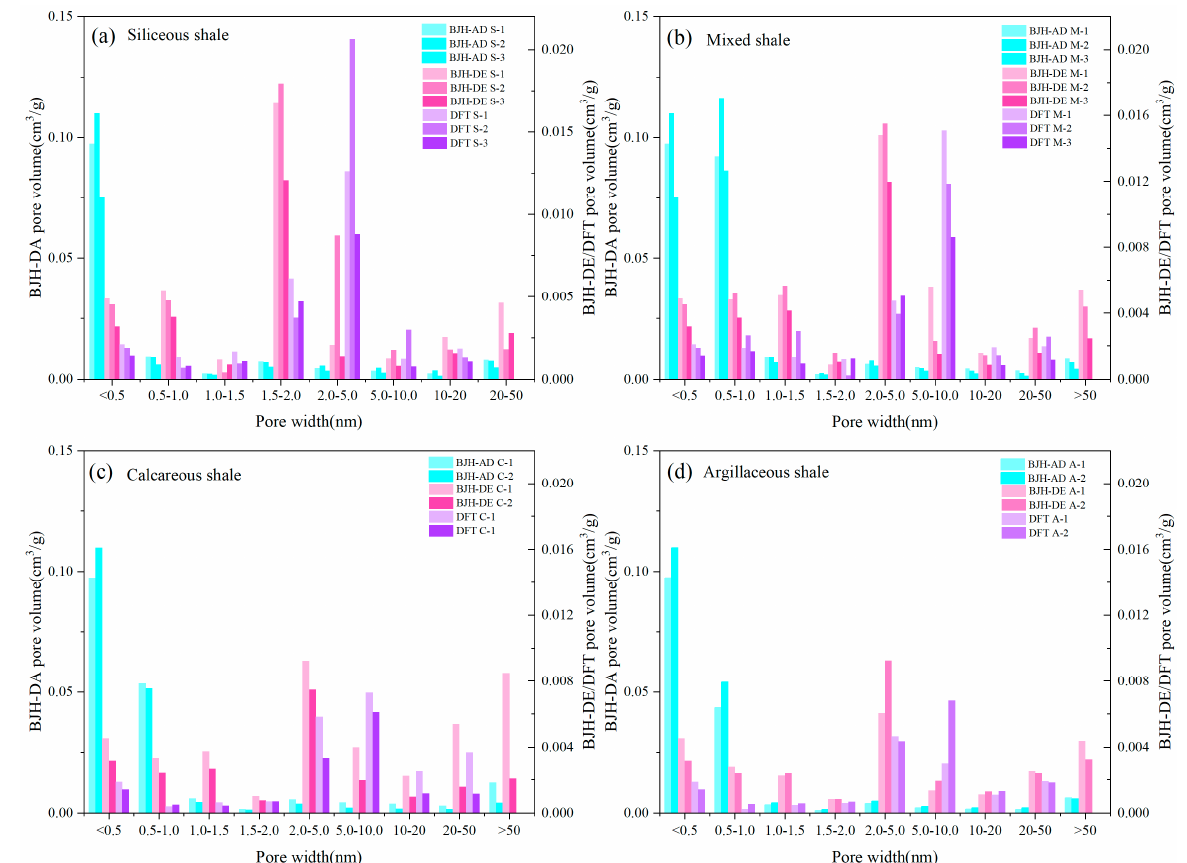
Figure 11. The PSD of PV and SA of different BJH and DFT models according to the data from N 2 adsorption experiments: ( a ) PV and SA distribution of siliceous lithofacies; ( b ) PV and SA distribution of mixed lithofacies; ( c ) PV and SA distribution of calcareous lithofacies; ( d ) PV and SA distribution of argillaceous lithofacies.